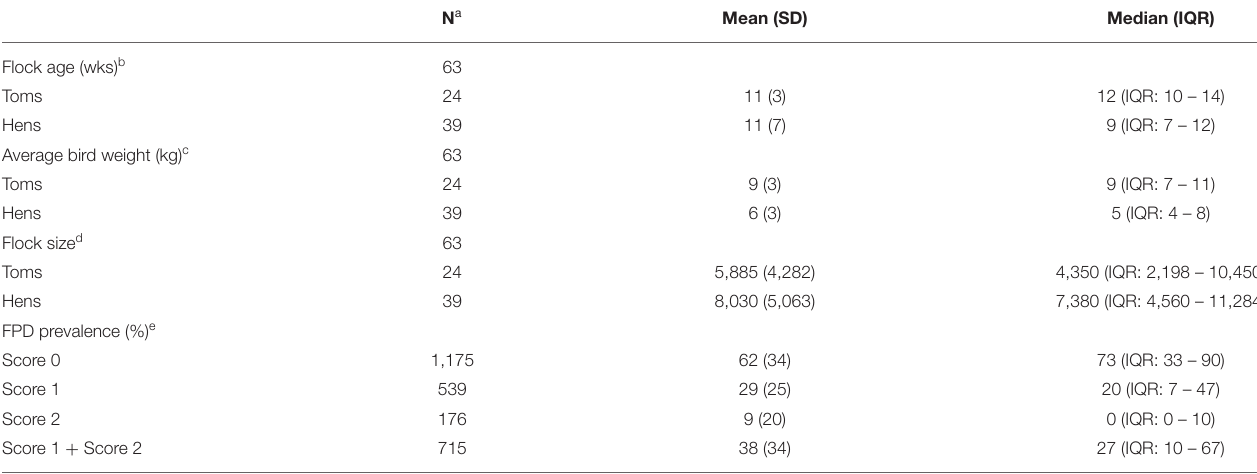
TABLE 3 | Descriptive characteristics of 63 commercial turkey flocks were used in this